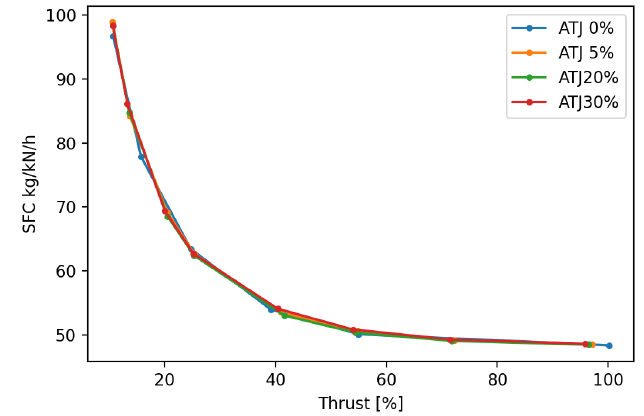
Figure 25. DGEN 380/ATJ: